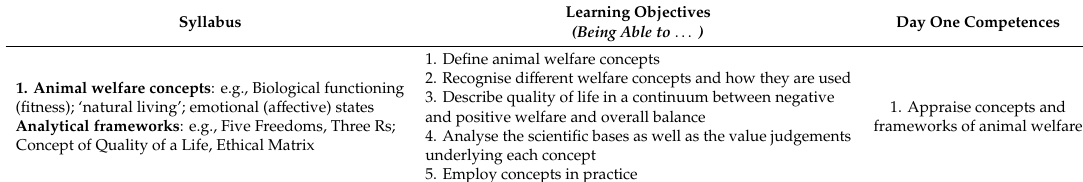
Table 1. EAEVE / FVE model animal welfare curriculum adopted in 2013. Syllabus Learning Objectives (Being Able to ...